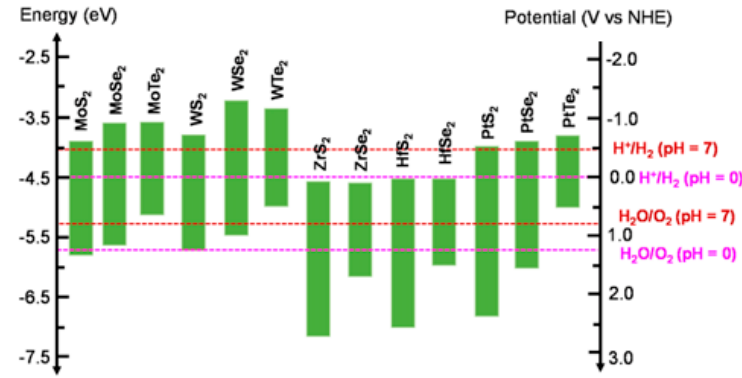
Figure 17. Positions of the band edges for some p ‐ type sulfides, selenides and tellurides relative to the thermodynamic levels for water splitting at different pH values. Energy values on the left axis are relative to the vacuum level (equivalent to the zero energy level of the free electron). Adapted from reference [120].